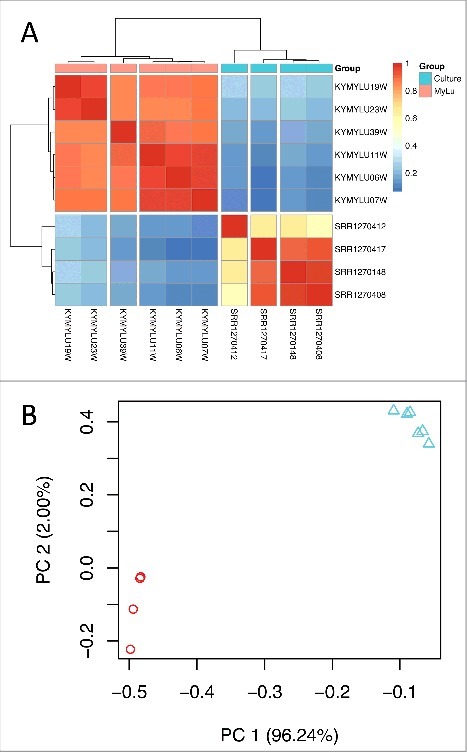
Gene expression of P. destructans in culture and when infecting M. lucifugus. (a) Hierarchical clustering of differentially expressed P. destructans trimmed mean of M-values (TMM)-normalized gene expression levels using Pearson correlation complete-linkage clustering with Euclidean distances. Scale shows Pearson correlation coefficient. Vertical breaks in the heatmap indicate clustering supported by bootstrap analysis at a confidence of 99% and the horizontal break indicates separate clustering of the different groups of samples. (b) Principal component analysis of global P. destructans gene expression using log2-transformed TMM-normalized expression levels. The principal components PC1 and PC2 represent 96% and 2% of the variance in the data, respectively. Triangles represent the MyLu samples and circles represent the culture samples.